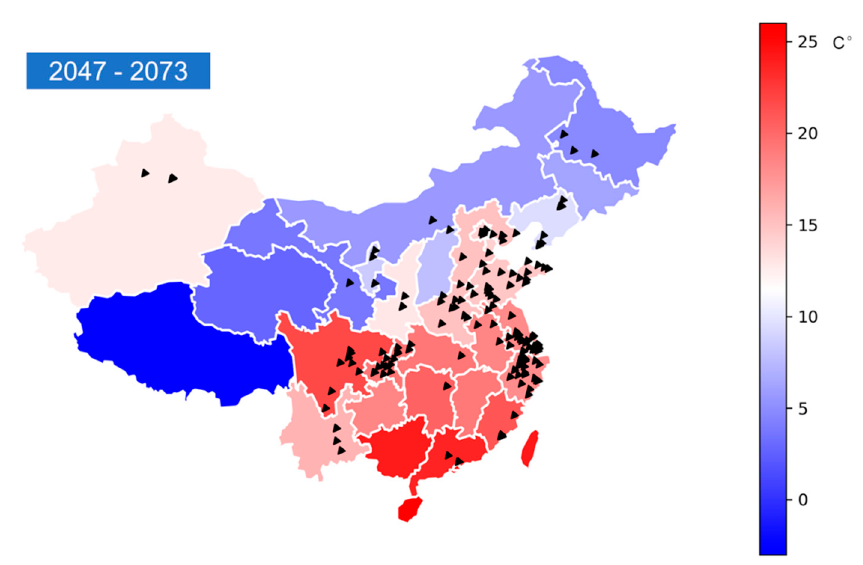
Figure A3. Annual average temperature levels in mid-term future (2047–2073), and locations of wastewater treatment plants included in the sample.